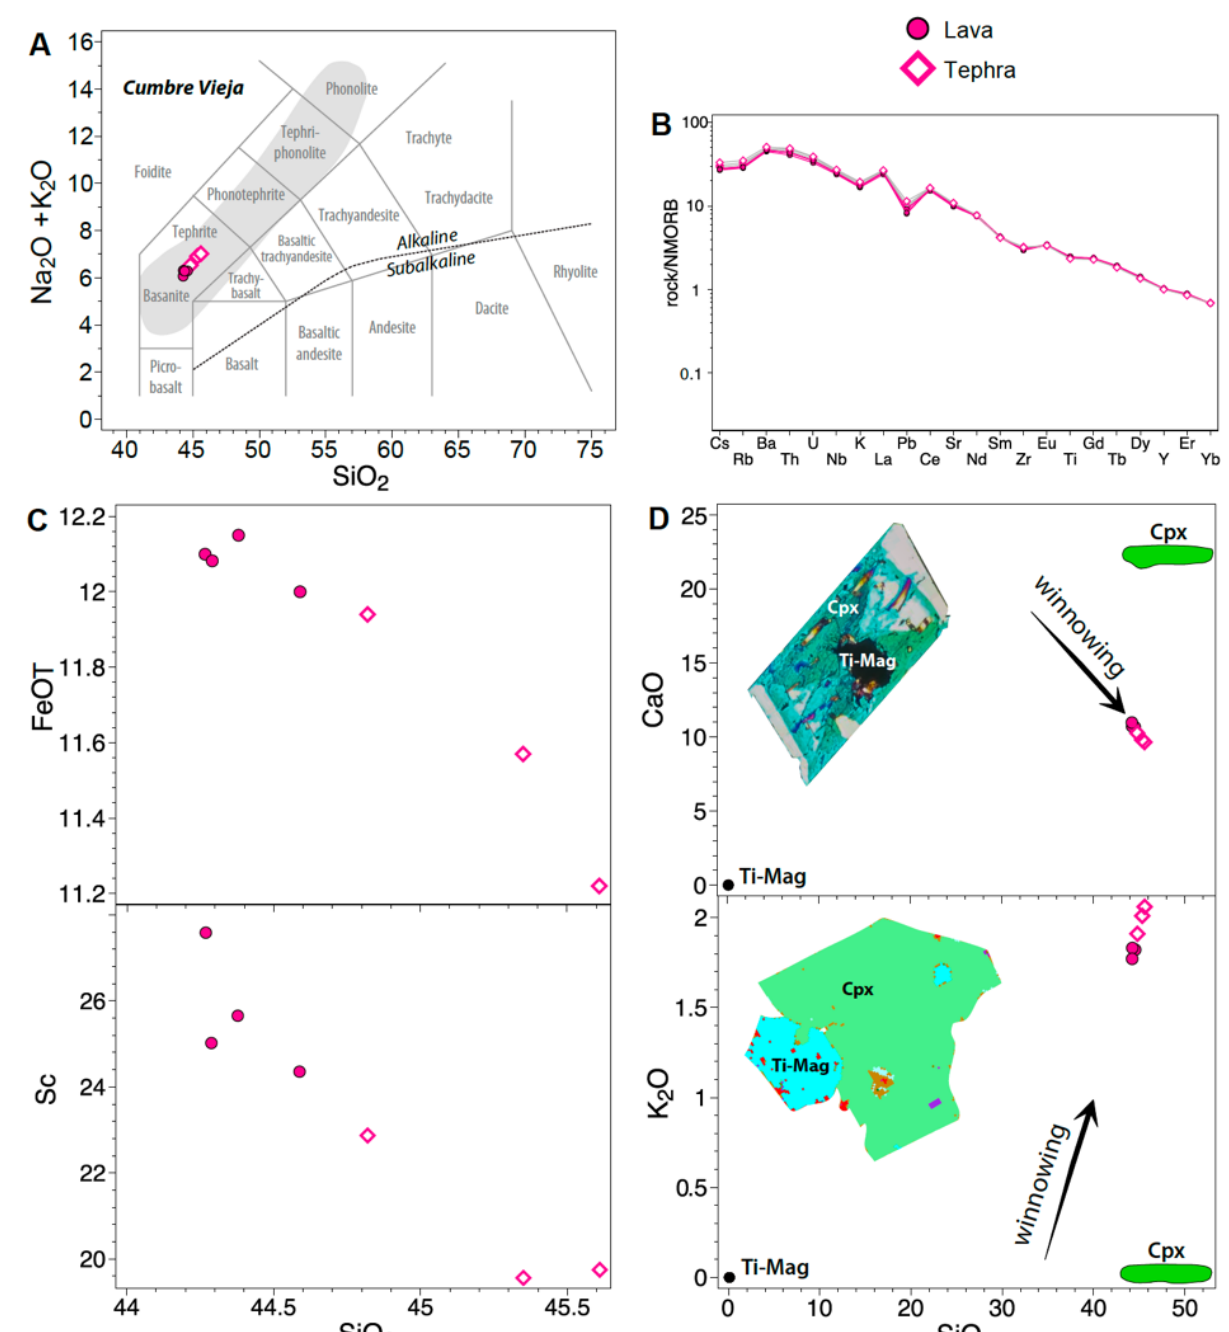
Figure 5: [A] TAS sample classification and historic Cumbre Vieja eruptions [Klügel et al. 2017]; [B] NMORB- normalized [Hofmann 1988] whole-rock diagram; [C] FeO and Sc vs SiO diagrams indicate clinopyroxene win- 2 nowing; refined by [D] CaO and K O vs SiO to include Ti-magnetite and confirmed by petrographic observations 2 2 ~85:15 clinopyroxene:Ti-magnetite ratio